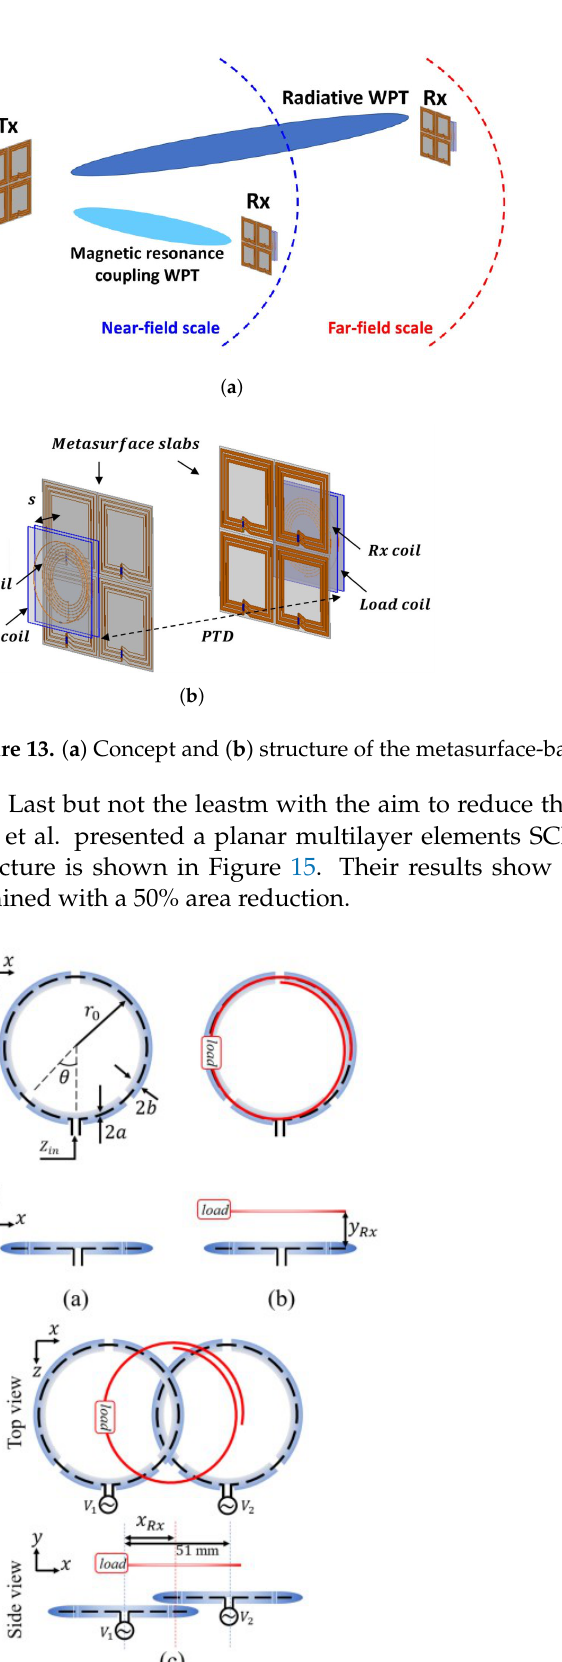
Figure 14. The WPT system configuration in [38]: ( a ) Tx coil in free space, ( b ) Rx in presence of the proposed Tx, ( c ) WPT system configurations with the Tx and Rx